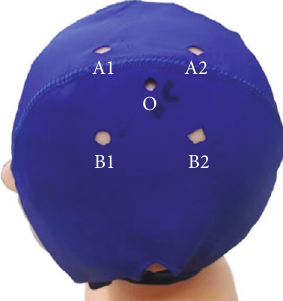
Figure 2: TI stimulation cap. O is the position of hot point. A1-A2 are the positions of two electrodes of one tACS channel in which the peak to peak stimulation intensity is 2mA, and the frequency is 2000Hz. B1-B2 are the positions of two electrodes of another tACS channel in which the peak to peak stimulation intensity is 2mA, and the frequency is 2020Hz. The distance between the position centers of every two electrodes is